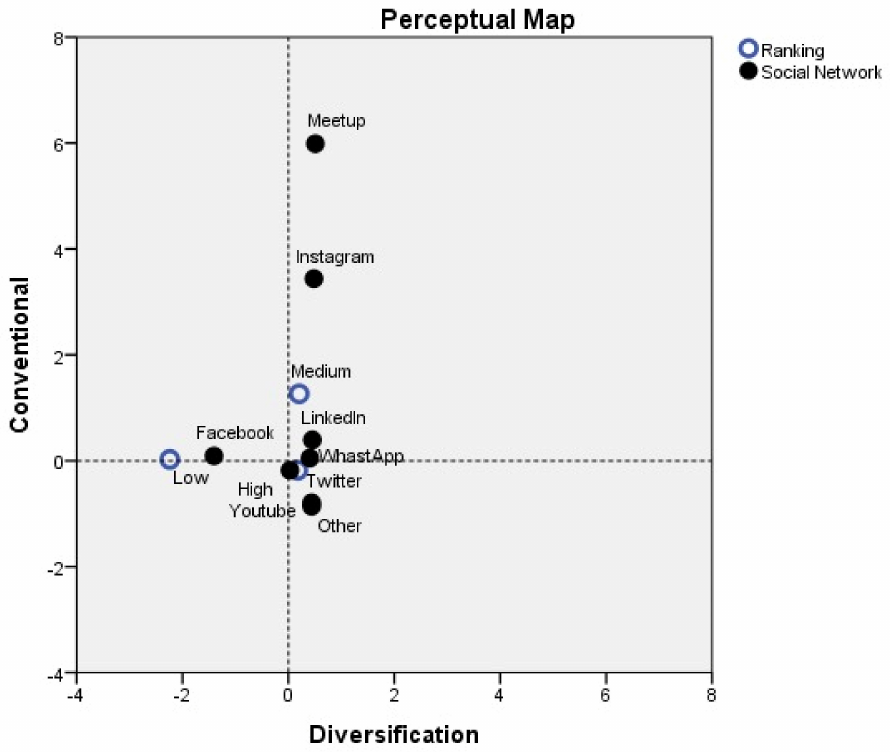
Figure 8. Correspondence analysis between positioning and traffic to the portal obtained from social networks. Note: constructed from consolidated and weighted data from the Similarweb